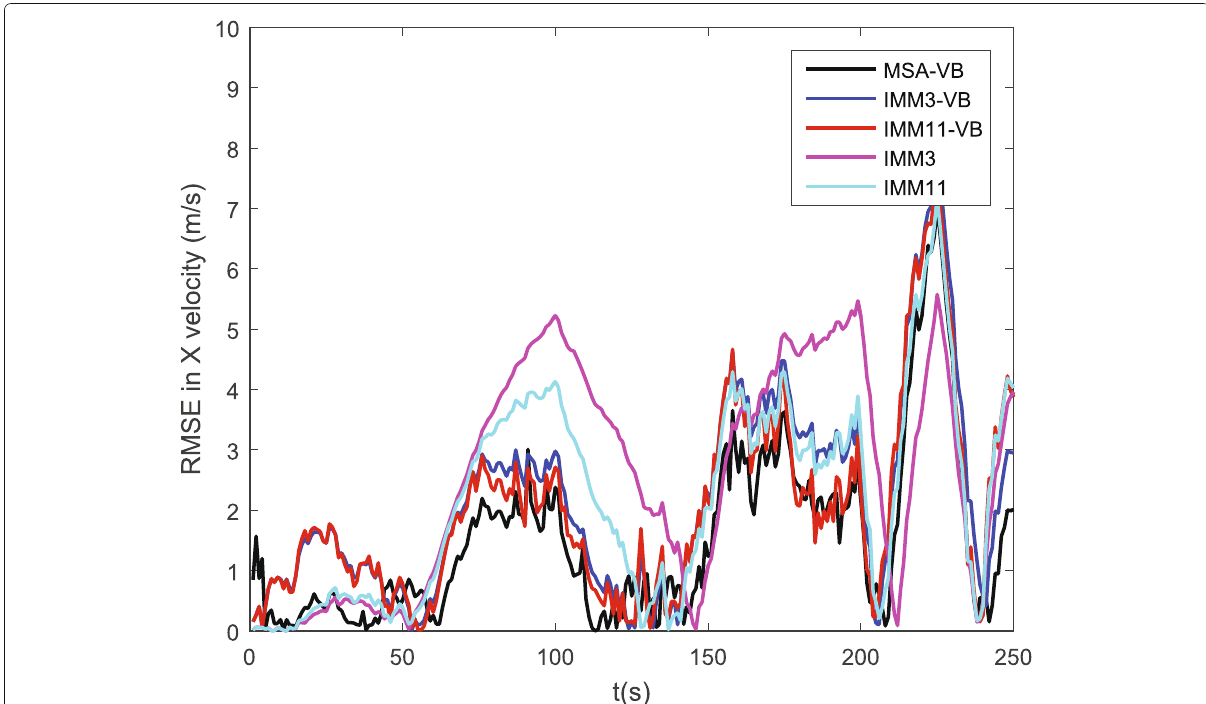
Fig. 3 RMSEs in X Velocity of the proposed algorithm, IMM3, IMM11, IMM3-VB, and IMM11-VB in scenario 1